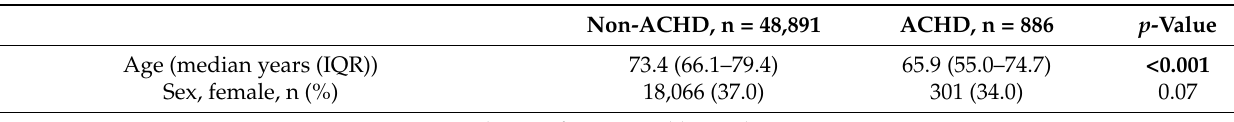
Table 1. Baseline characteristics and demographic data of the study cohort, stratified by presence and absence of congenital heart disease (ACHD = adult congenital heart disease).